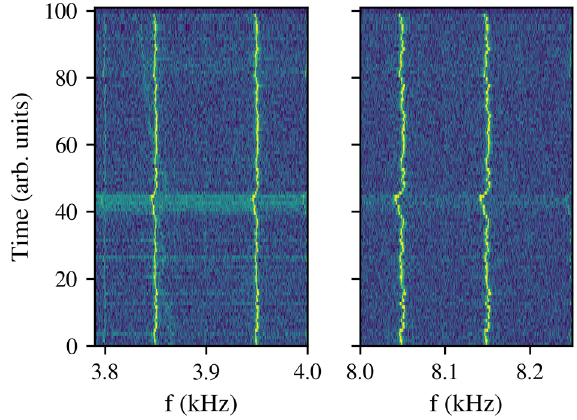
FIG. 27. The UPS spectrogram in normal mode of operation centered around the low-frequency cluster (left) and the high- frequency cluster (right). The color-code represents the